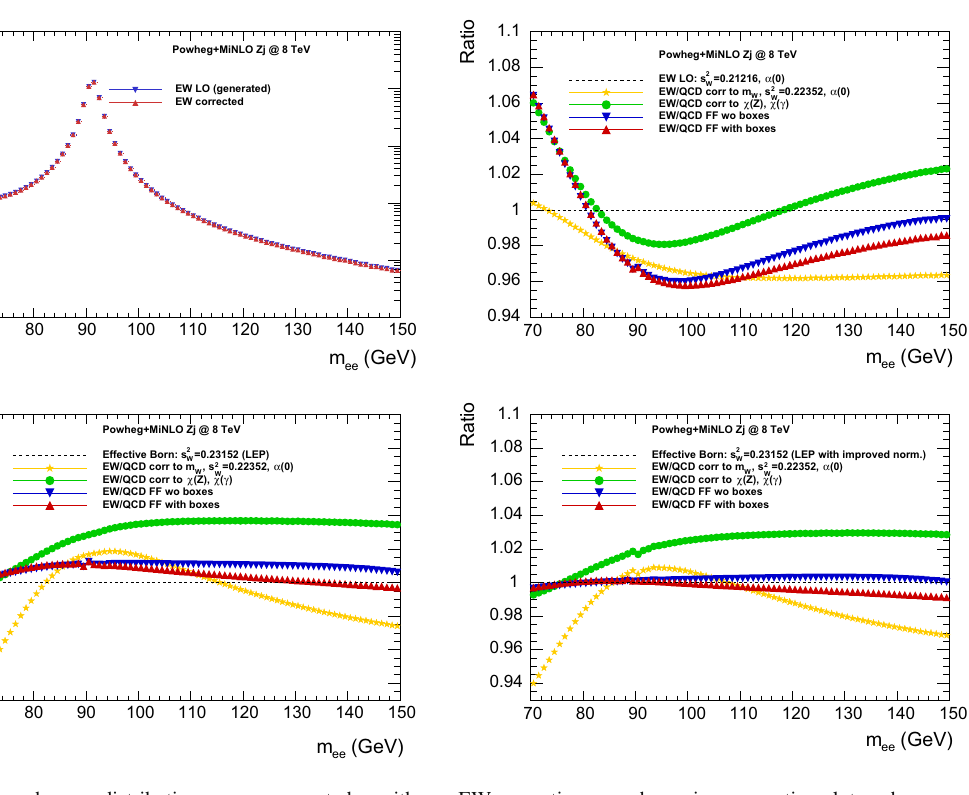
EW corrections are shown in consecutive plots, where as a reference (black dashed line) respectively: (i) EW LO α( 0 ) scheme (top-right), (ii) effective Born (LEP) (bottom-left) and, (iii) effective Born (LEP with improved norm.) (bottom-right), was used